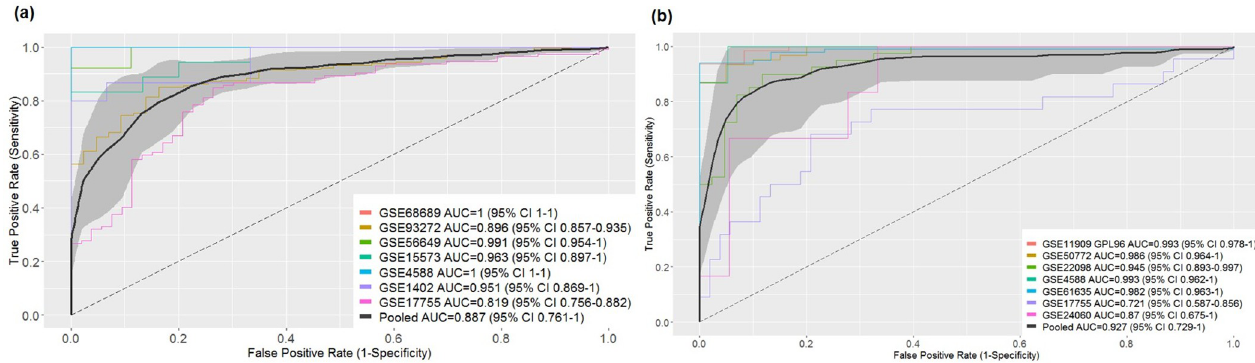
Fig 2. Receiver operating characteristic curves of RA and SLE. (a) RA datasets and (b) SLE datasets. A perfect classifier must have an AUROC of 1, while a random classifier has an AUC of 0.5. Here, the summary curve is a composite of the individual studies from PBMC, WB, and CD4 T and B Cells samples with AUROC scores of 0.887 and 0.927 for RA and SLE